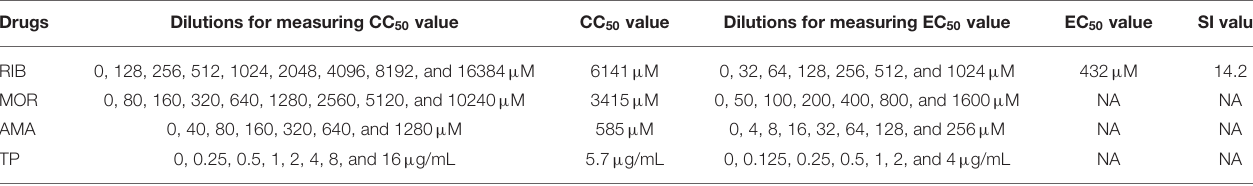
TABLE 1 | Drugs subjected to serial 2-fold dilutions for measuring their CC 50 , EC 50 , and SI values. Drugs Dilutions for measuring CC 50 value CC 50 value Dilutions for measuring EC 50